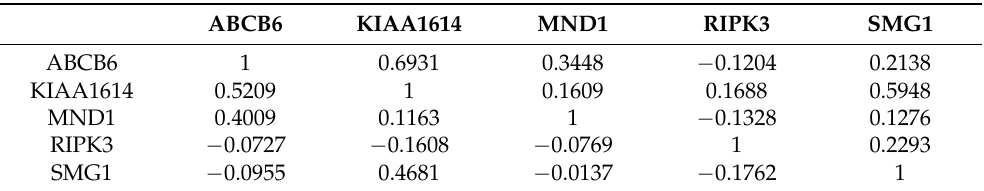
Table 4. Pairwise Pearson’s correlation coefficients: The upper triangle is for TPM data, and the lower triangle is for EC data. ABCB6 KIAA1614 MND1 RIPK3 SMG1 ABCB6 1 0.6931